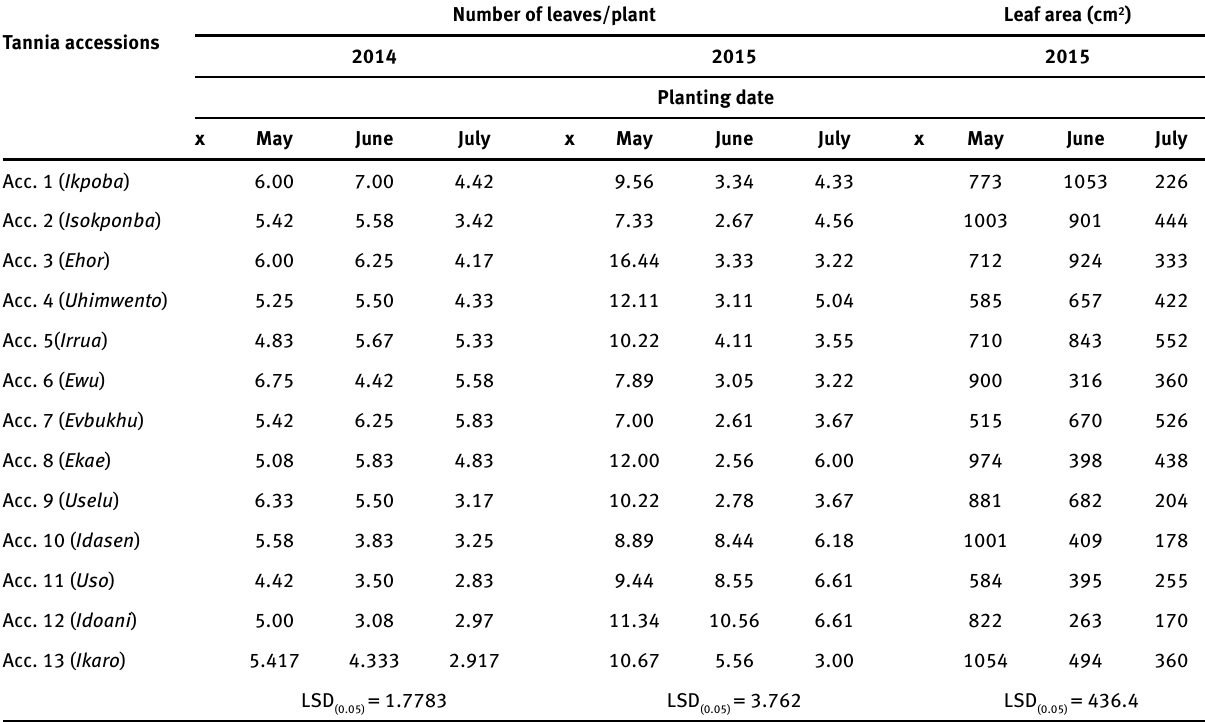
Table 6: Effect of interaction between planting date and tannia accessions on number of leaves/plant in 2014 and 2015, and on leaf area in 2015 cropping seasons Tannia